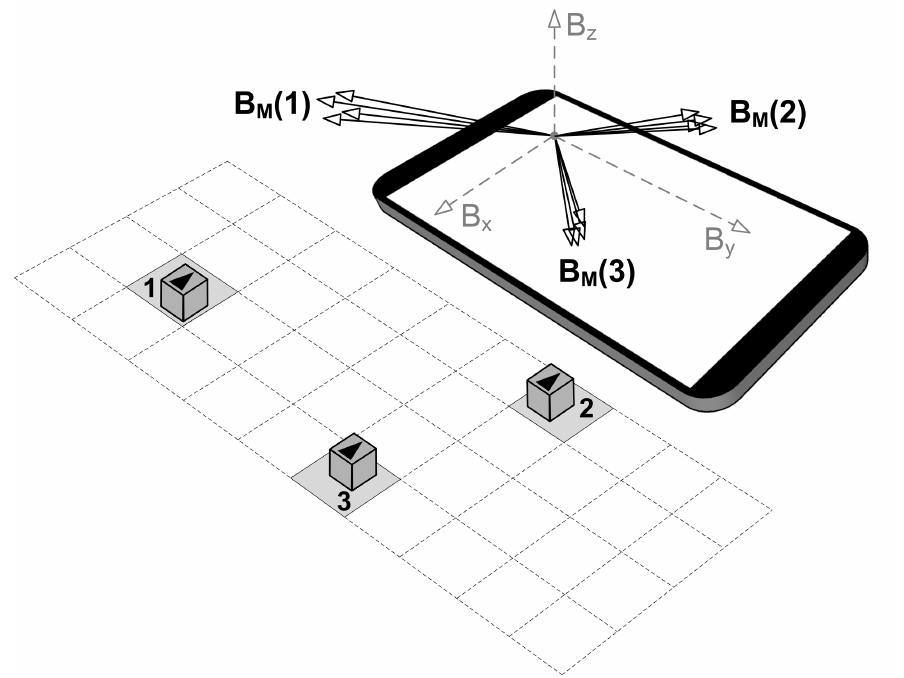
Figure 2. Magnetic field fingerprinting—mapping locations of the permanent magnet with the corresponding sensor